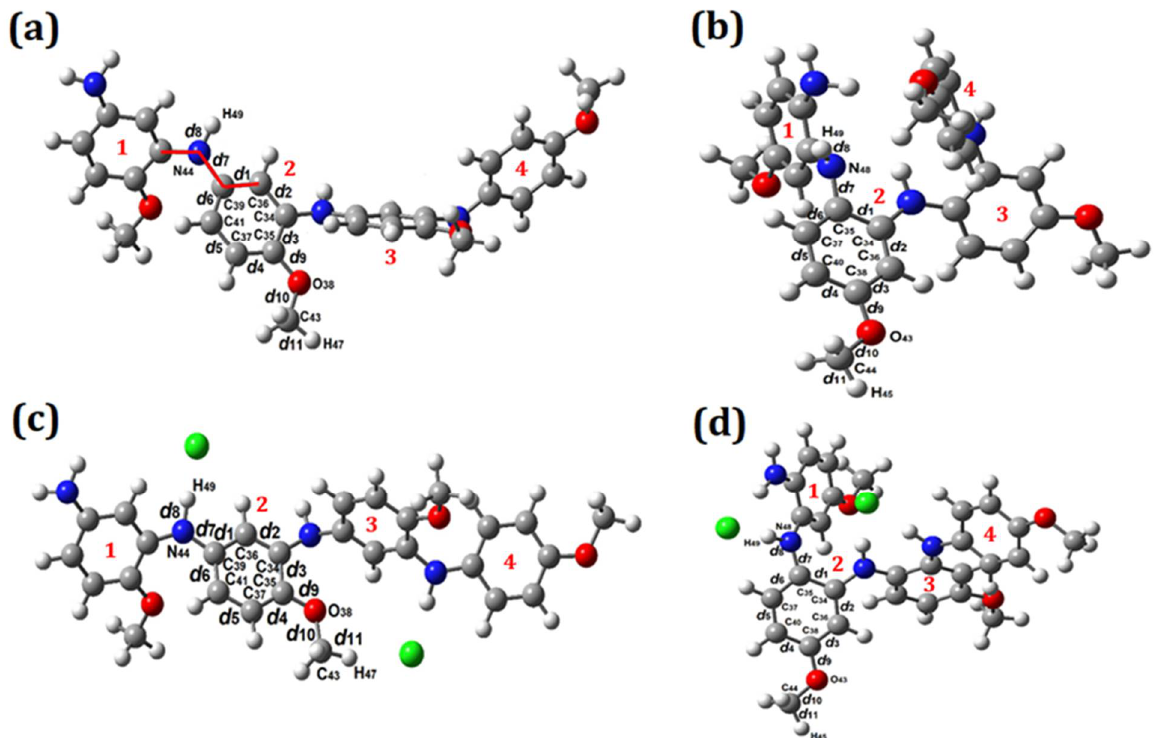
Figure 9. Geometric optimization of PPA HT , Cl–PPA HT , PPA HH , and Cl–PPA HH tetramers: ( a ) undoped PPA HT ; ( b ) undoped PPA HH ; ( c ) doped Cl–PPA HT ; ( d ) doped Cl–PPA HH . Interatomic distances are identified as d 1 to d 11 . Numbers 1–4 represent the repeated unit from each polymer. Table 3. Interatomic distances (Å) and angle values observed in PPA HT , Cl–PPA HT , PPA HH , and Cl–PPA HH